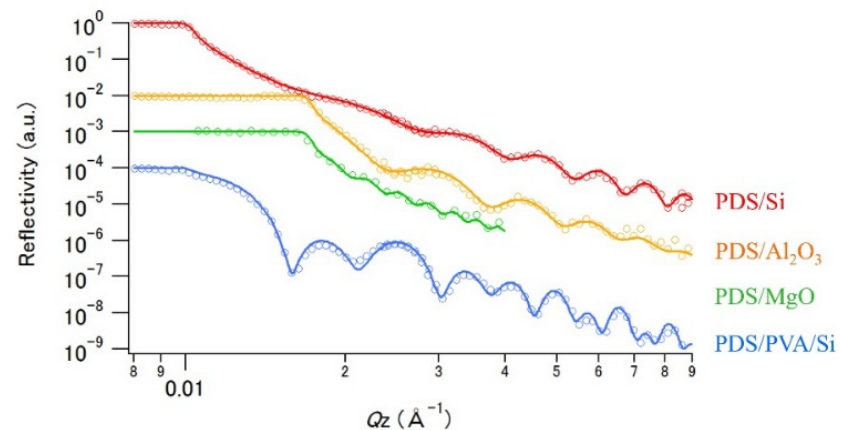
Figure 3. Neutron reflectivity profiles of the PDS thin layer samples. The circles represent the experimental data, and the solid lines represent the best-fit calculated neutron reflectivity (NR) profiles.